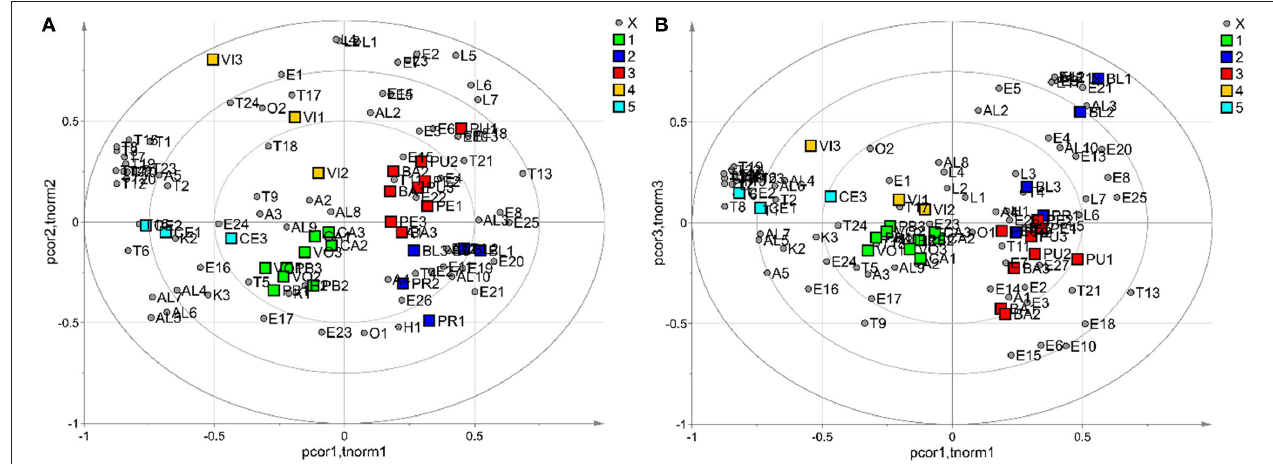
FIGURE 2 | The PCA model: biplot obtained, considering the first two principal components (A) and biplot built, considering the first and the third principal components (B) ; observations are coloured according to the cluster; grey circles indicate the VOCs.